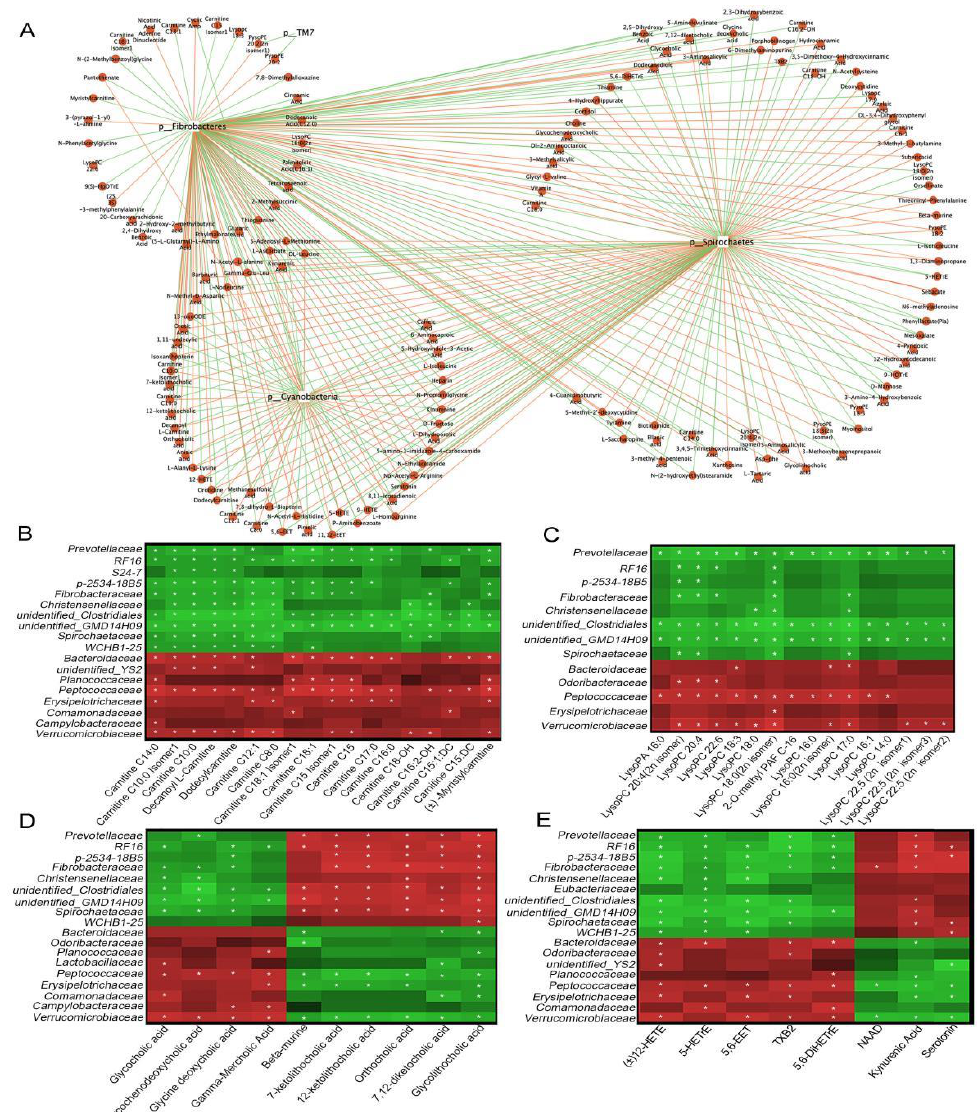
Figure 6. Functional correlations between fecal metabolites and the main microbiota. ( A ) Network diagram showing microbiota at the phylum level, with 182 differential metabolites (VIP ≥ 1, p < 0.05, FC ≥ 2 or FC ≤ 0.5). The red line represents a positive correlation, and the green line, a negative correlation. Heat maps represent Spearman correlations for microbiota and differential metabolites of acylcarnitines ( B ), lysophospholipids ( C ), bile acids ( D ), and oxidized lipids ( E ). R values are represented by gradient colors; red and green cells = positive and negative correlations, respectively. Asterisks indicate significance at * p < 0.05.